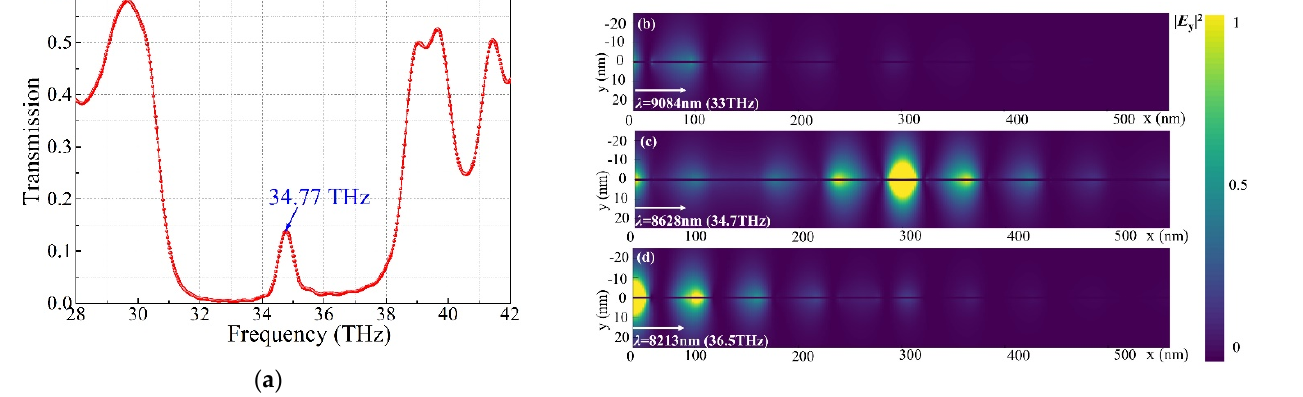
Figure 3. ( a ) Transmission spectrum of the graphene waveguide with bias voltage 60 V. The normalized electric-field patterns from the FDTD simulation for different incident wavelengths: ( b ) 9084 nm, ( c ) 8628 nm and ( d ) 8213 nm.